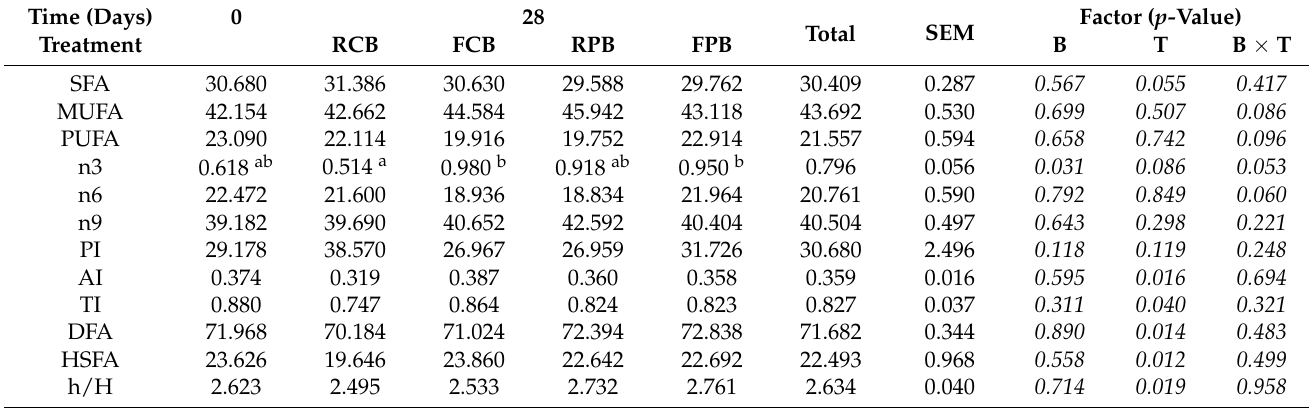
Table 6. Fatty acid indexes of egg yolk depending on packaging and storage